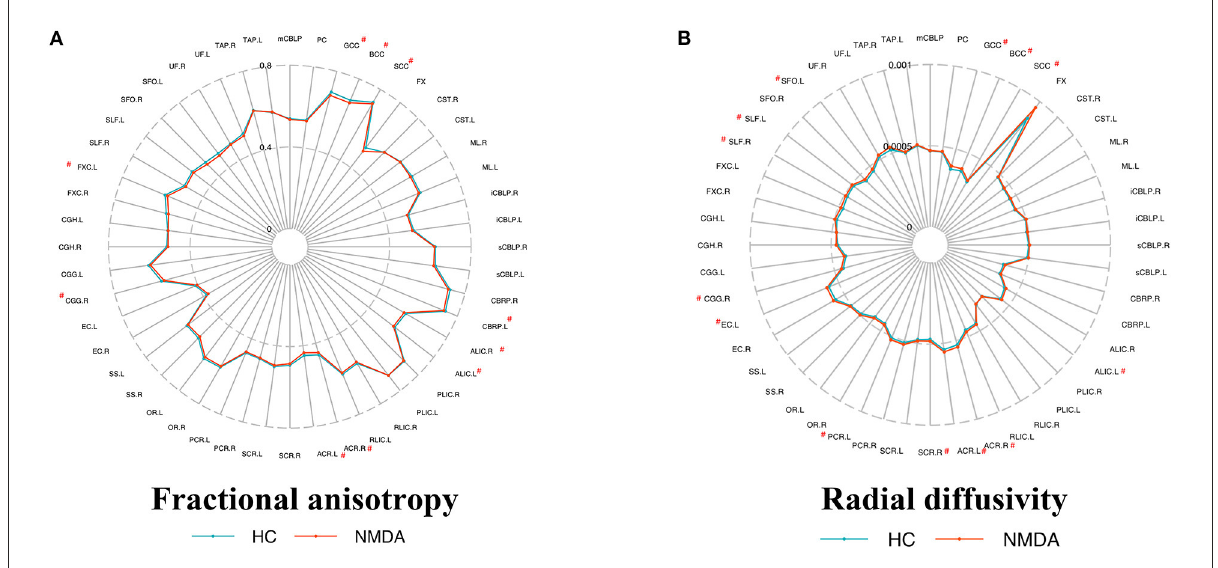
FIGURE2 Metrics of the white matter in patients and controls by atlas-based analysis. Fractional anisotropy (A) and radial diffusivity (B) metrics of ICBM-DTI-81 WM label atlas, respectively. Atlas that shows a significant difference ( p < 0.05 FDR correction) is marked with a “#” at the top corner. No significant differences in axial diffusivity and mean diffusivity were observed between the two groups. All abbreviations are listed in Supplementary Table 2.